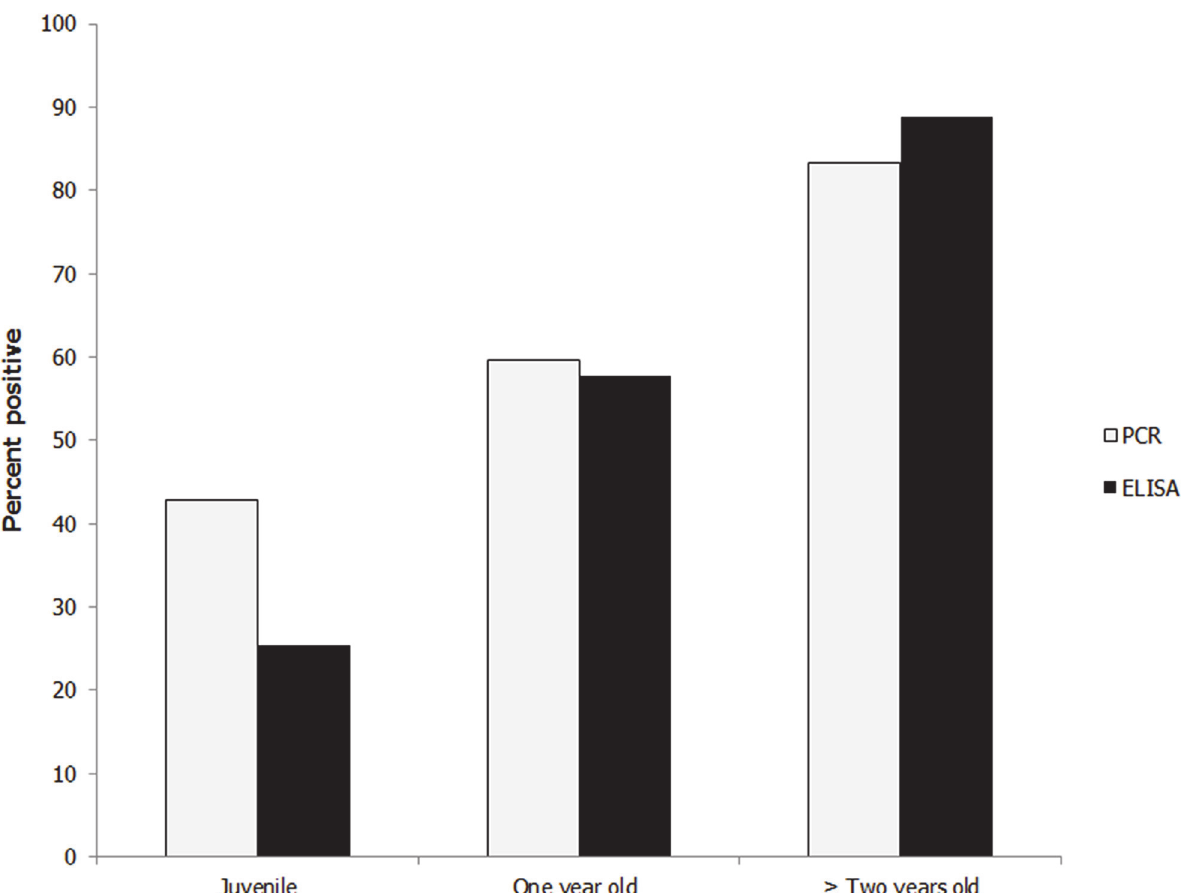
Fig 2. Percent mink positive for viral DNA (PCR) and AMDV antibodies (ELISA) in three different age groups; juvenile (24 of 56 mink and 14 of 55 mink, respectively); one year old (28 of 47 mink and 26 of 45 mink, respectively) and mink two years or older (15 of 18 mink and 16 of 18 mink, respectively).